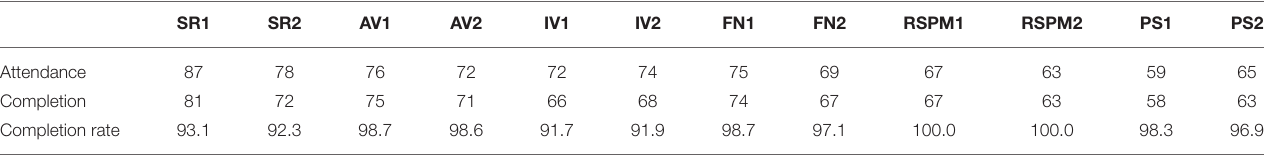
TABLE 2 | Multidomain cognitive training in-class test results.